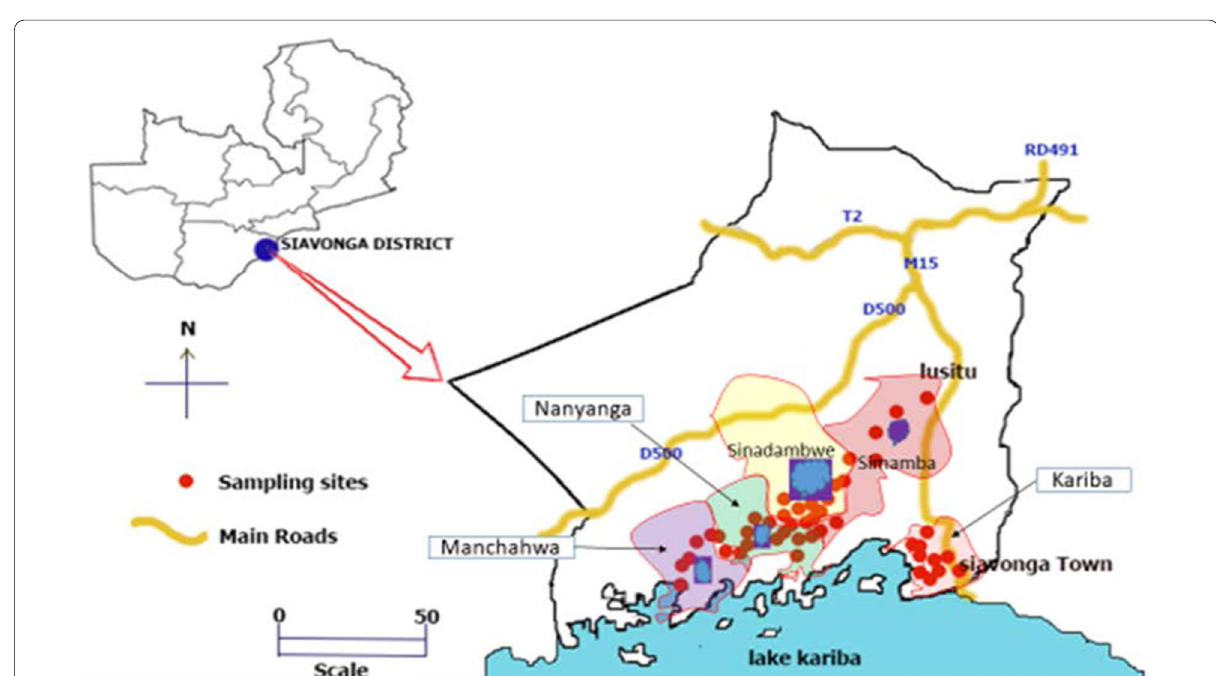
Fig. 2 Map of Siavonga District, Zambia, showing Manchahwa, Nanyanga, Sinadambwe, Simamba and Kariba Local Government Wards. The purple cloud-like shapes in squares show the uranium mining sites. Kariba ward does not have a uranium mining site as